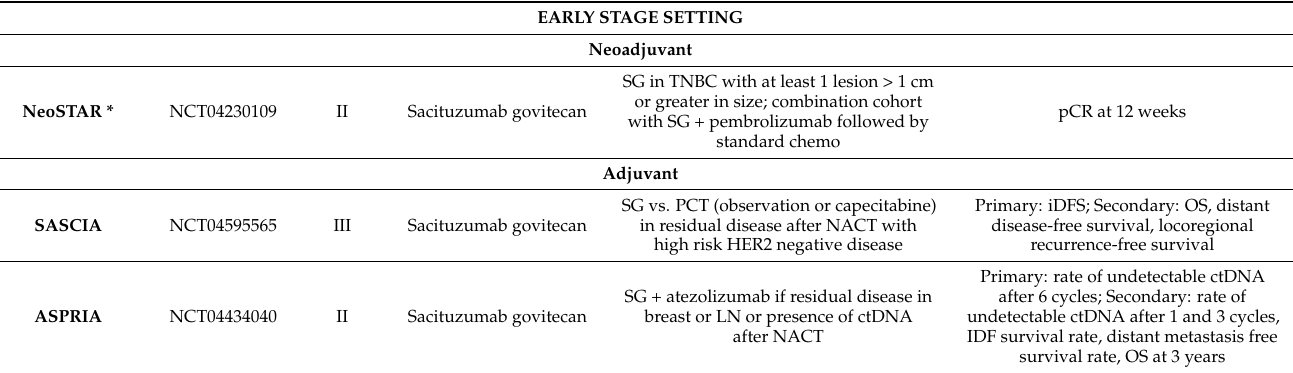
Table 5. Ongoing and completed clinical trials involving Trop-2 inhibitors in the early stage setting as neoadjuvant and adjuvant therapy for